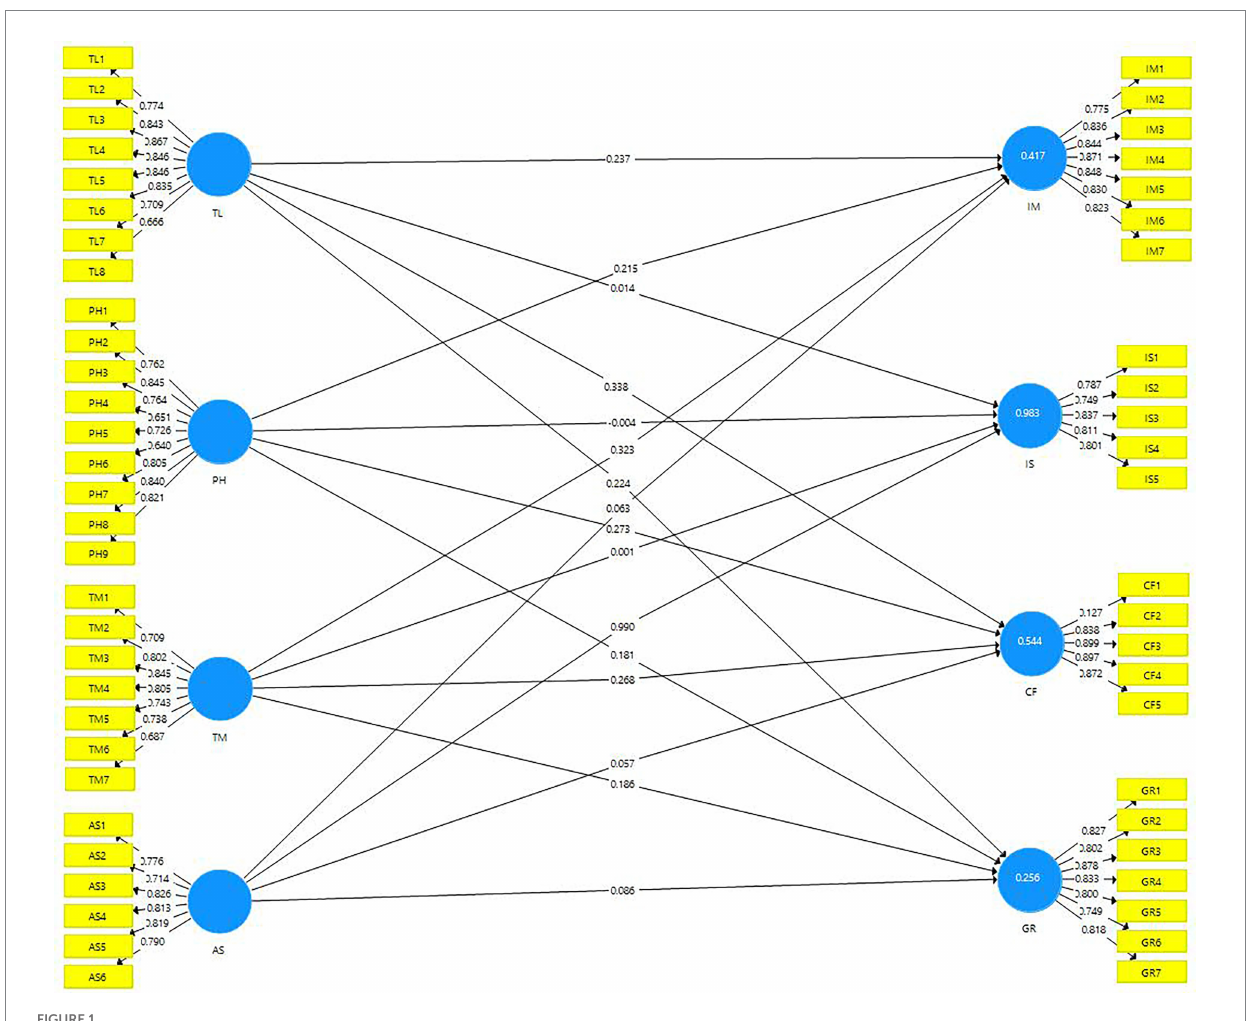
FIGURE 1 Measurement model assessment.